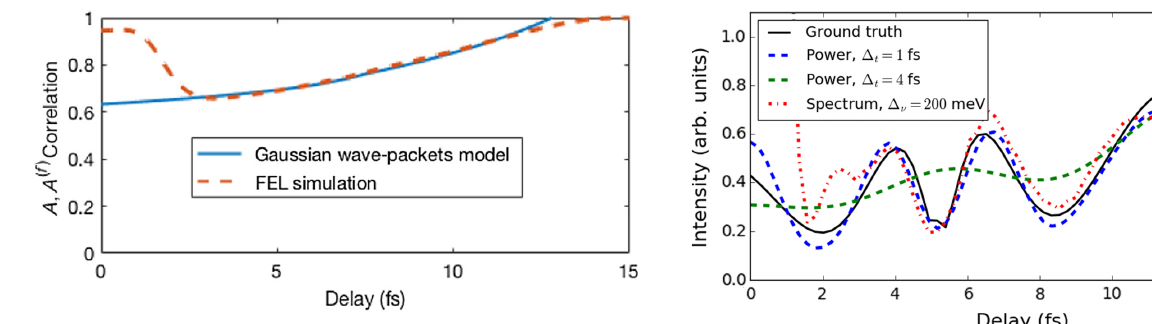
FIG. 4. Illustration of PPGI using simulation parameters from Table I and measurements of either the power (time domain) or spectrum (frequency domain). The ground truth is taken from the Eggholder artificial landscape